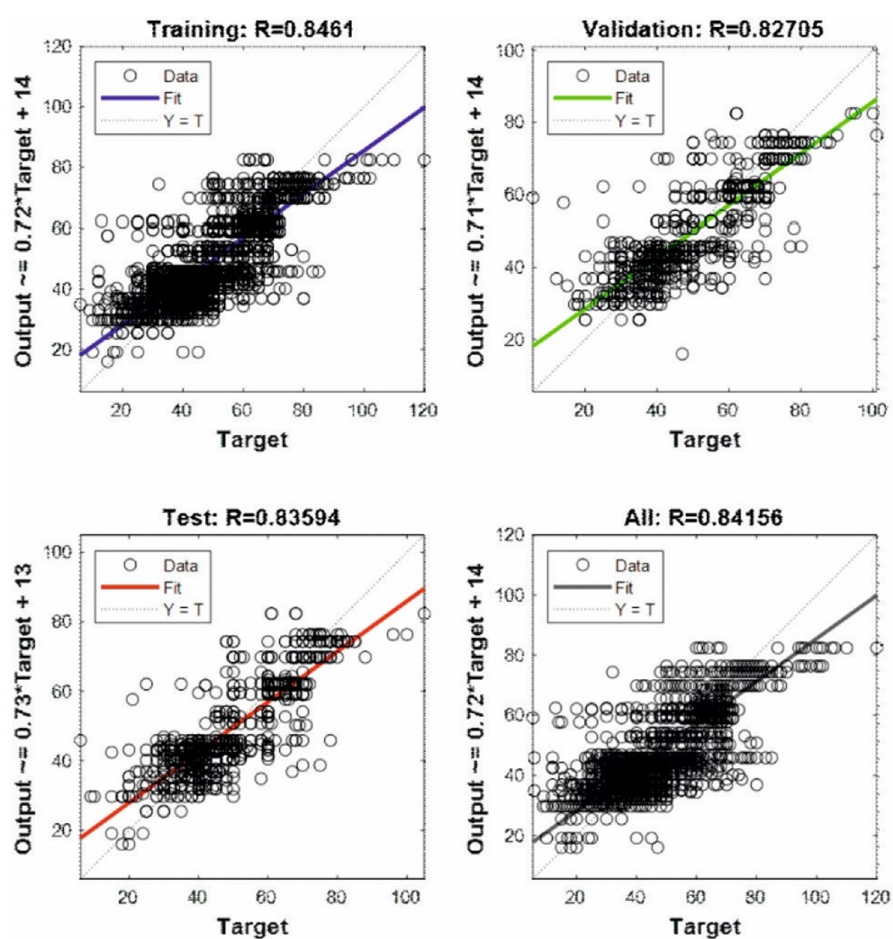
Fig. 10 Cross-correlations between the predicted (out- put) and the measured (target) ROP values for model